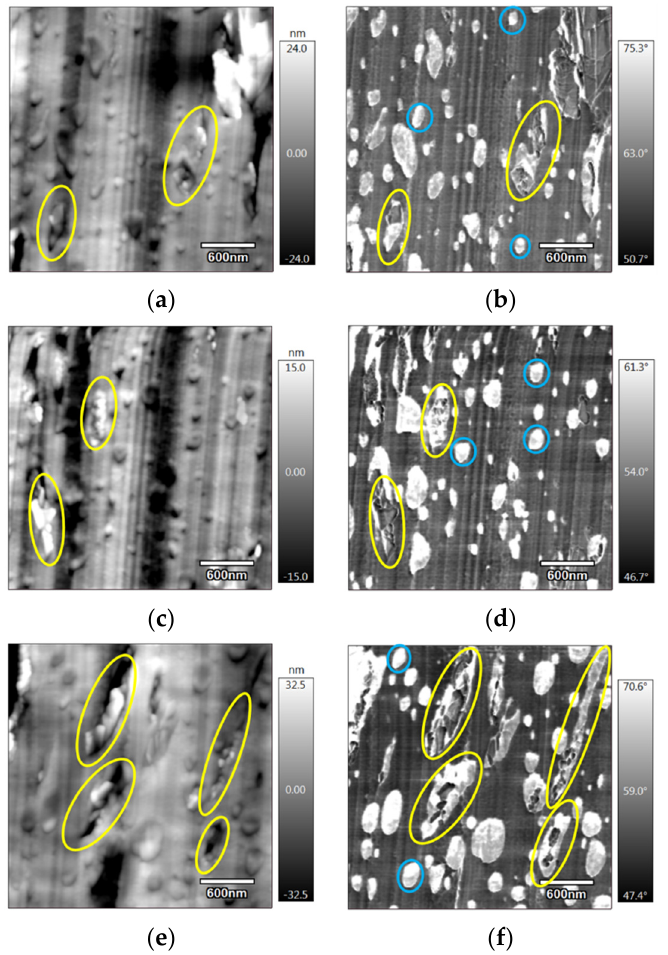
Figure 5. ( a , c , e ) AFM topography; ( b , d , f ) the corresponding phase images of ( a , c , e ), respectively, of the injection-moulded PLA/PCL/10 wt.% M5 (the yellow circles surround the PCL particles containing GNPs and the blue circles surround the pure PCL nodules.).